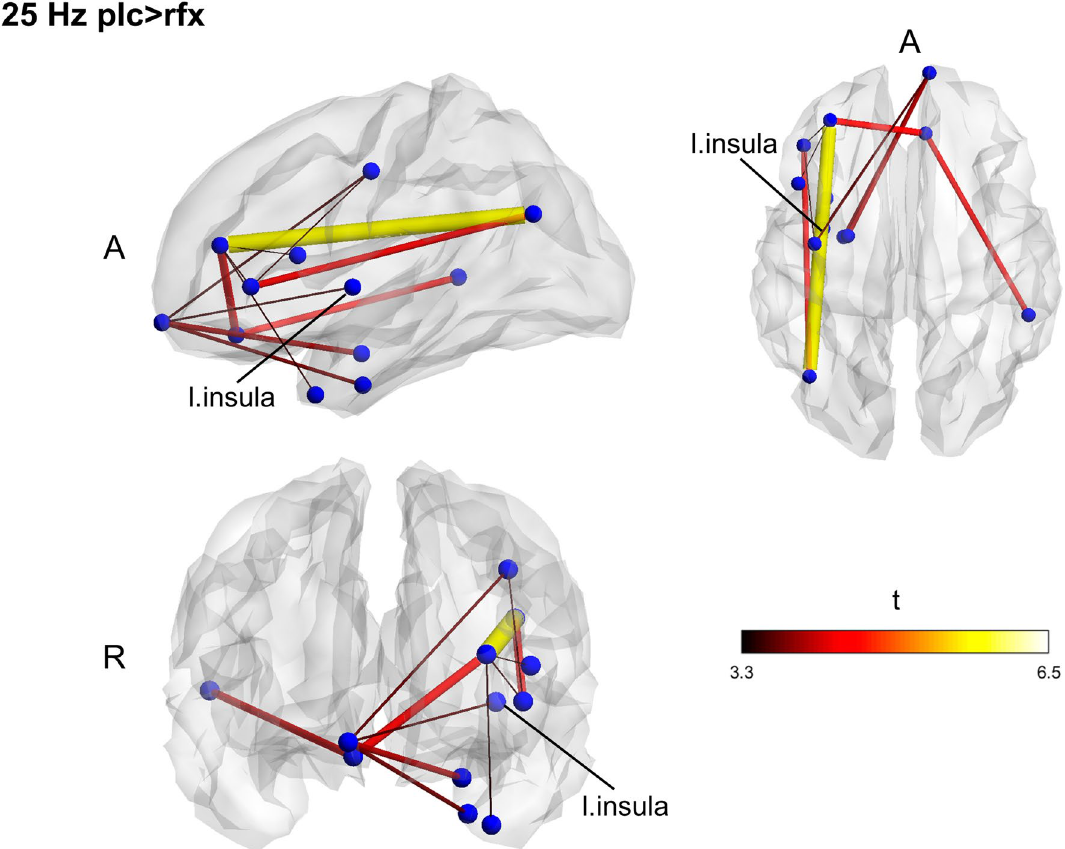
Figure 2. Between groups functional connectivity comparison in post-treatment session. The placebo group displays two networks with increased connectivity in slow and fast beta band (25 Hz) compared to the Rifaximin group. Clusters of higher connectivity are located mainly in the left hemisphere, involving frontal, temporal, and parietal areas. To note the presence of the insular cortex within the networks. Color and size of the edges are proportional to t-statistic (t) value ( A anterior, R